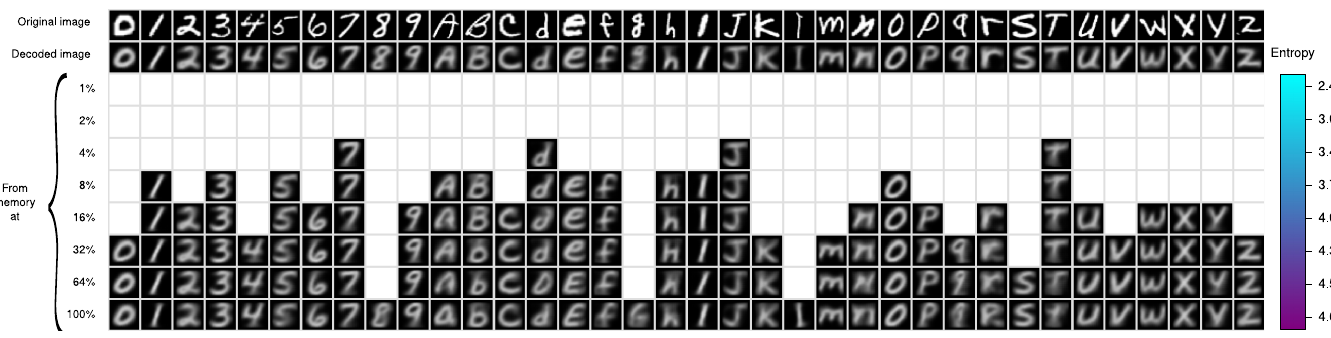
Fig 10. Moderate quality cues. EMNIST-36 Symbols recovered with moderate quality cues as a function of the entropy.